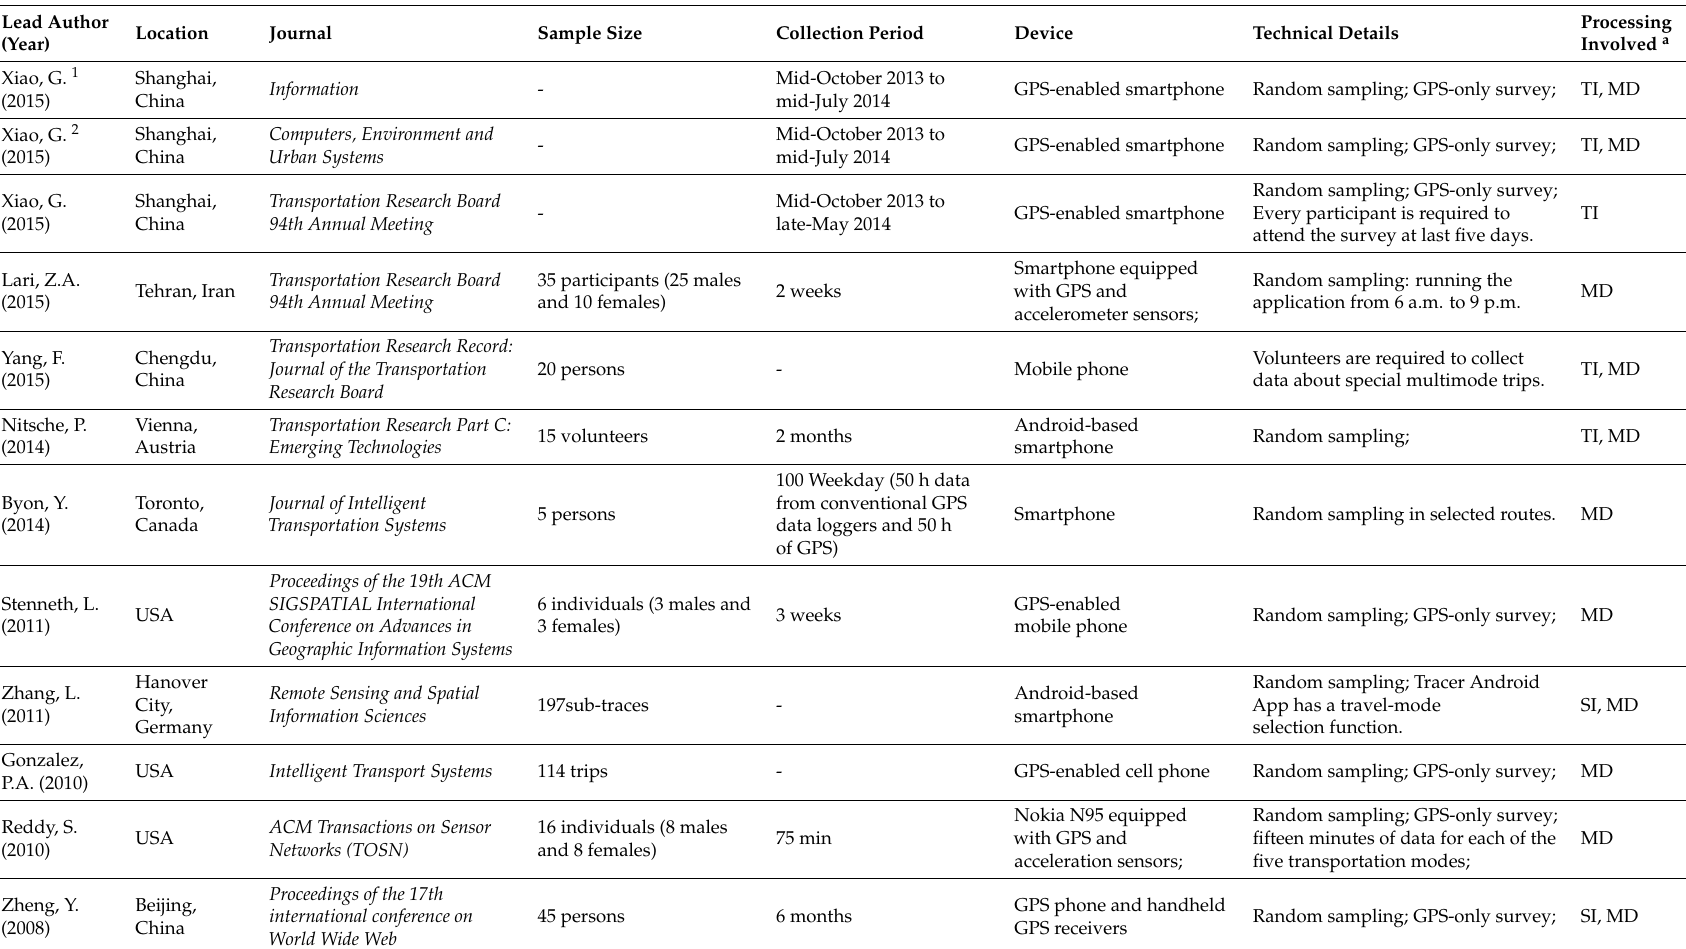
Table 2. Summary of studies included in this systematic